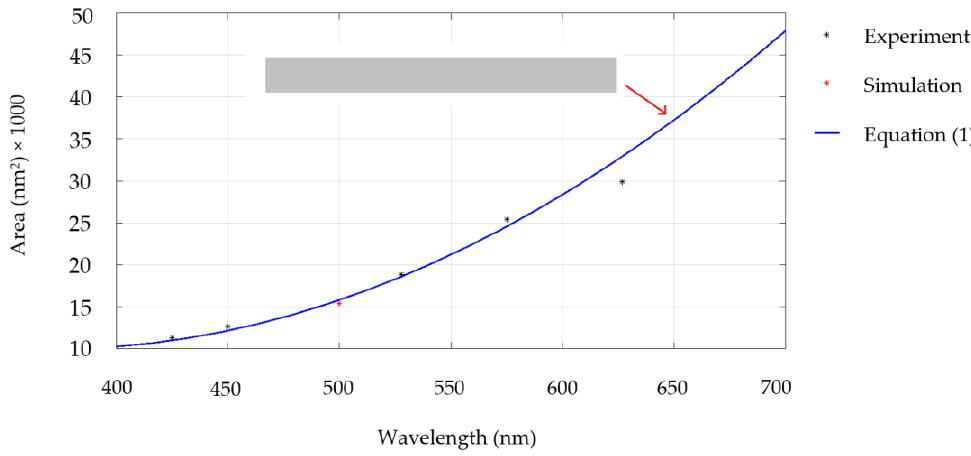
Figure 10. Comparison of our simulation results and the experimental results from Schade et al.